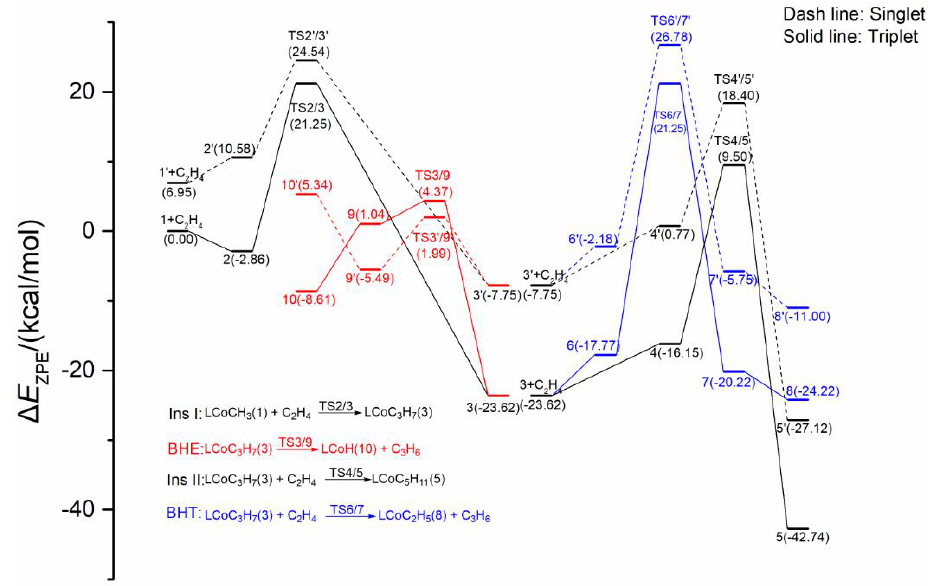
Figure 1. Energy profiles (kcal / mol) for the first and second ethylene coordination and insertion (black), β -H transfer ( BHT , in blue) and β -H elimination ( BHE , in red) catalyzed by the neutral cobalt complex in singlet (dash line) and triplet (solid line) spin states. The energies are relative zero-point energies with respect to the reactants: LCoCH 3 ( 1 ) (triplet state) and C 2 H 4 . The number n corresponds to Co(0)- n , the TS m / n refers to the transition state between the two intermediates Co(0) - m and Co(0)- n . The n’ was used to distinguish structures between the two spin states, as is the same in the following Figures.